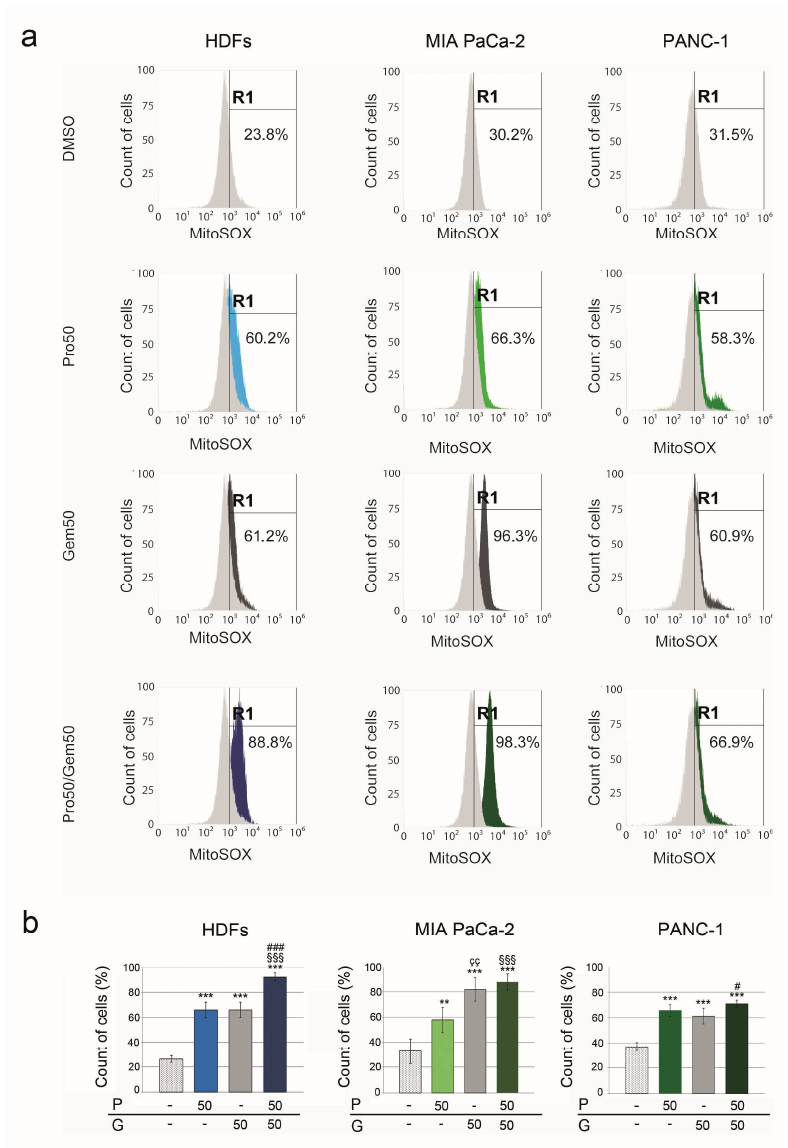
Figure 6. PRO, GEM and PRO/GEM increased mitochondrial ROS levels. ( a ) Flow cytometry analysis of MitoSOX signal in HDF, MIA Paca-2 and PANC-1 cells treated with DMSO, PRO50 µ M, GEM50 µ M or PRO50 µ M + GEM50 µ M. Measurements were performed using the BL3 (off 488 laser) 695/40 nm. Y -axis = percent of count of cells acquired (3 × 10 4 ); x -axis = fluorescence intensity of the MitoSOX dye; R1 = gating strategy based on DMSO cell population used as a control. ( b ) Graph columns represent mean of MitoSOX signal ± SD, expressed as percent values. The symbol * denotes statistical significance versus control group; ç, statistical significance of GEM versus the corresponding concentration of PRO; §, #, statistical significance of PRO/GEM combination versus the corresponding concentration of PRO or GEM. P = protopine; G = gemcitabine. # p < 0.05; **, çç, p < 0.01; ***, §§§, ### p <